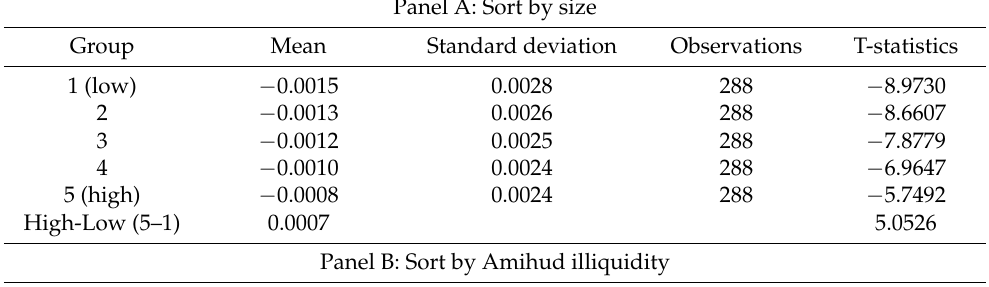
Table 10. Overnight return by firm characteristics. This table presents the overnight returns of portfolios grouped on firm characteristics. Each portfolio is constructed based on an indicator (size, Amihud illiquidity, or turnover) using a monthly frequency. The stocks are divided into five groups based on the indicator at each month. Panel A: Sort by size Group Mean Standard deviation